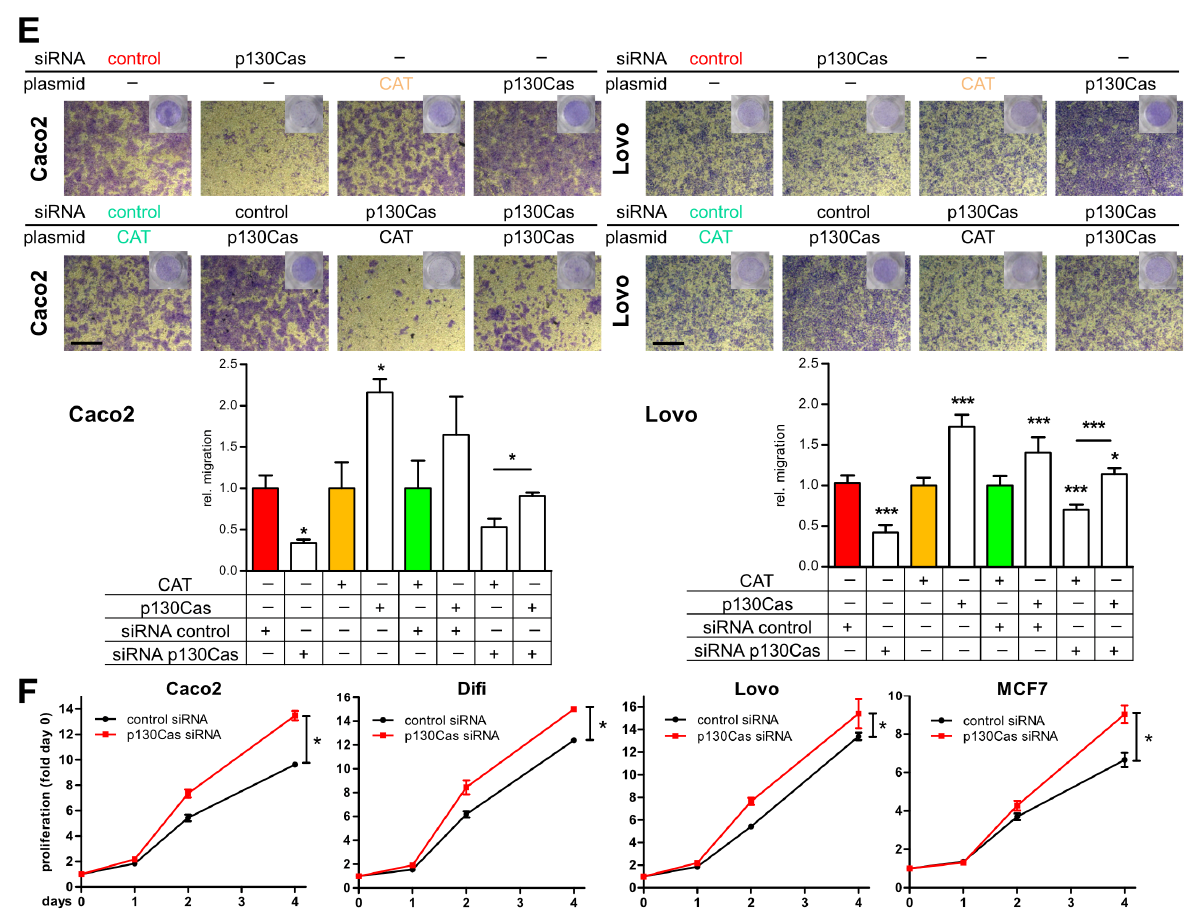
Figure 2. p130Cas is active, strongly expressed, and drives migration but inhibits proliferation in CRC cell lines. ( A , B ) Active p130Cas (phosphorylated, p-p130Cas) and p130Cas protein ( A ) and mRNA ( B ) levels in CRC and breast cancer cell lines. Cells were seeded at 1 × 10 5 cells/well in 6-well plates and cultured in regular medium for 48 h. ( A ) Expression and phosphorylation (p-p130Cas, pooled phospho-antibodies) in whole-cell extracts (WCE, 20 µ g) were investigated by immunoblot (IB). Band intensities were quantified by densitometric analysis. The ratio of p-p130Cas and p130Cas was calculated and related to MCF7 levels (set to 1). Average values from three independent experiments are shown. ( B ) mRNA expression in indicated cell lines was normalized to MCF7 levels (dashed line). ( C , D ) Cells were transfected with siRNA targeting p130Cas or control siRNA and harvested at 48 h. Knockdown of p130Cas, as well as reduced ERK1/2 phosphorylation, were confirmed by IB ( C ) and qPCR ( D , BCAR1 only). ( E ) Cells transiently transfected with p130Cas or CAT-control plasmids and indicated siRNAs were subjected to serum-stimulated migration assay. Upper panel, shown are representative images from at least two independent experiments. Scale bars, 500 µ m. Lower panel, shown are fold migration (controls (CAT, siRNA control or CAT+control siRNA) were set to 1) and SEM of triplicates. ( F ) Proliferation assay after p130Cas knockdown was performed as described in Materials and Methods. Statistical differences between growth curves were calculated with the CGGC permutation test [31]. Ns, not significant. * p < 0.05. ** p < 0.01. *** p <